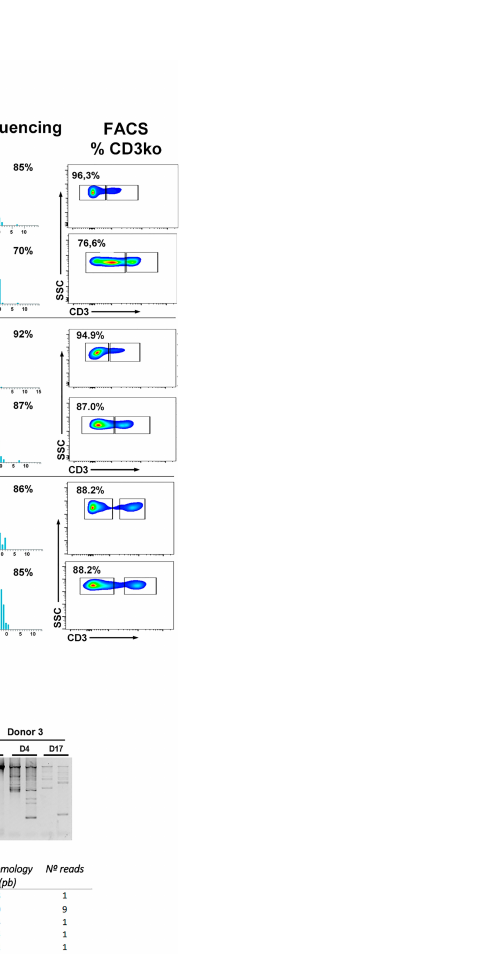
FIGURE 2 Indel analysis of CRISPR/Cas9 treated T cells. (A) Top, scheme of the PCR product analyzed after TRAC genome editing using Cas9/RNP TRAC RNPs. Bottom, analysis of the genome editing ef fi cacy using deep sequencing and Cas analyzer (left), Sanger sequencing and ICE analysis (Middle) and fl ow cytometry (Righ). TCR genome editing was performed in primary T cells from three different donors (indicated at the left) at day 4 and day 17 after isolation. Left: Indel frequency obtained by Cas analyzer are shown for each day (left-bottom in each day). Insertions (Ins.) and deletions (Del.) sizes are visualized as graphs. Middle: Indel frequency obtainned by Sanger sequencing and ICE are show at the top-right corner of each graph. Graphs also display the inferred insertion and deletion (indel) distribution. Each bar shows the size of the insertion or deletion along with the percentage of genomes that contains it. Right: Flow cytometry dot-plots showing the percentage of TCR disruption, measured as the reduction of CD3 expression on edited cells. (B) Top: PCR primers used to detect large deletions at the TRAC locus located 2kb upstream and 2kb downstream the RNP target site. Bottom: Electrophoresis gel showing the different amplicons that arise after a PCR using the primers indicated to light up large deletions. PCRs were performed for three different donors at day 4 and day 17 as indicated. Non-edited T cells (WT) were used as controls for each donor. (C) Table showing the analysis of 13 different deletions found by bands isolation and Sanger sequencing. Deletion size, location and the presence of microhologies is